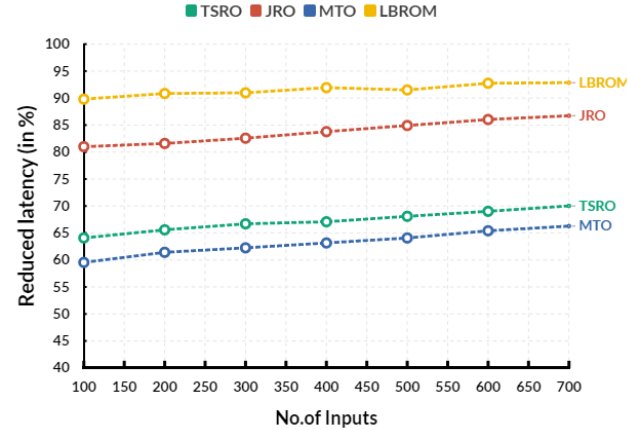
Figure 5. Comparison of reduced latency.